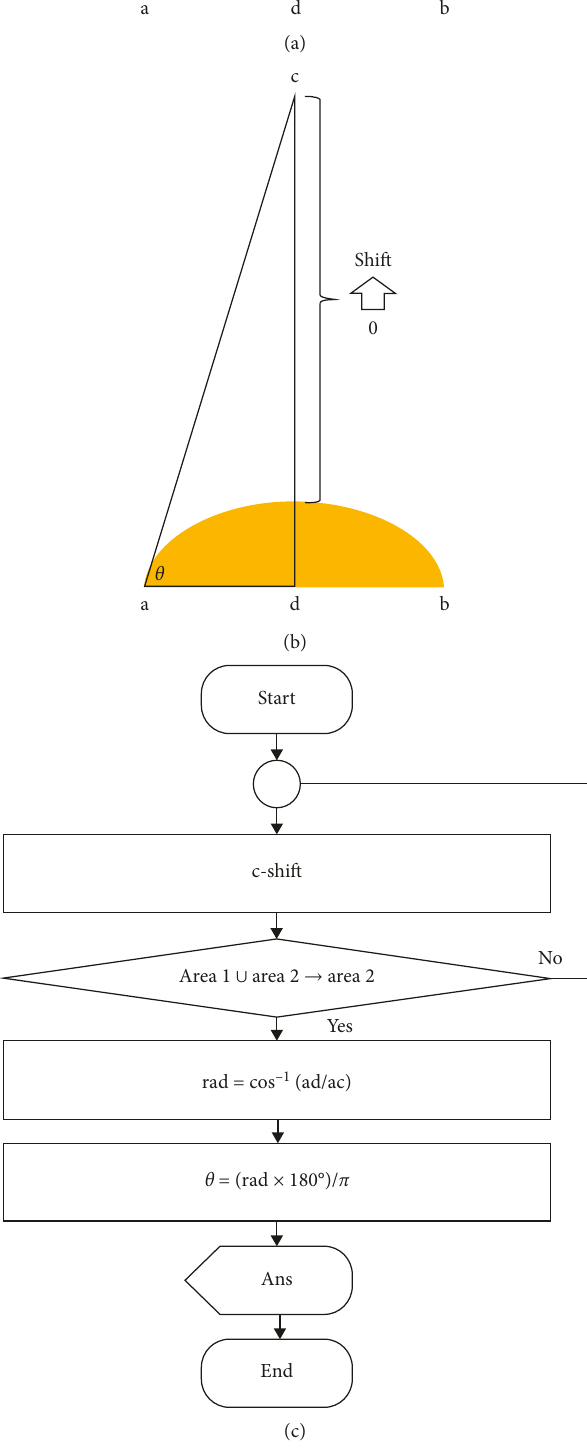
Figure 4: Developed algorithm for contact angle